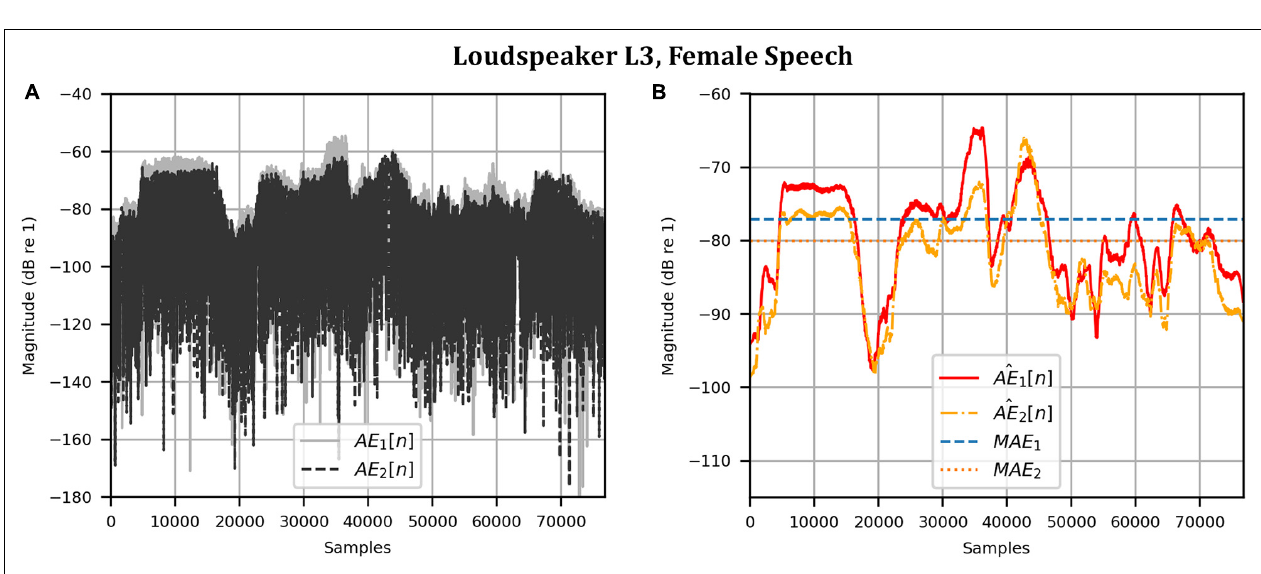
FIGURE 12 | Clinical booth: Target (blue solid) versus reproduced (red dashed) time domain waveforms of a female speech sample played from loudspeaker L3 (originally in the anechoic chamber) reproduced in the audiological booth: (A) Left microphone; (B) Right microphone.